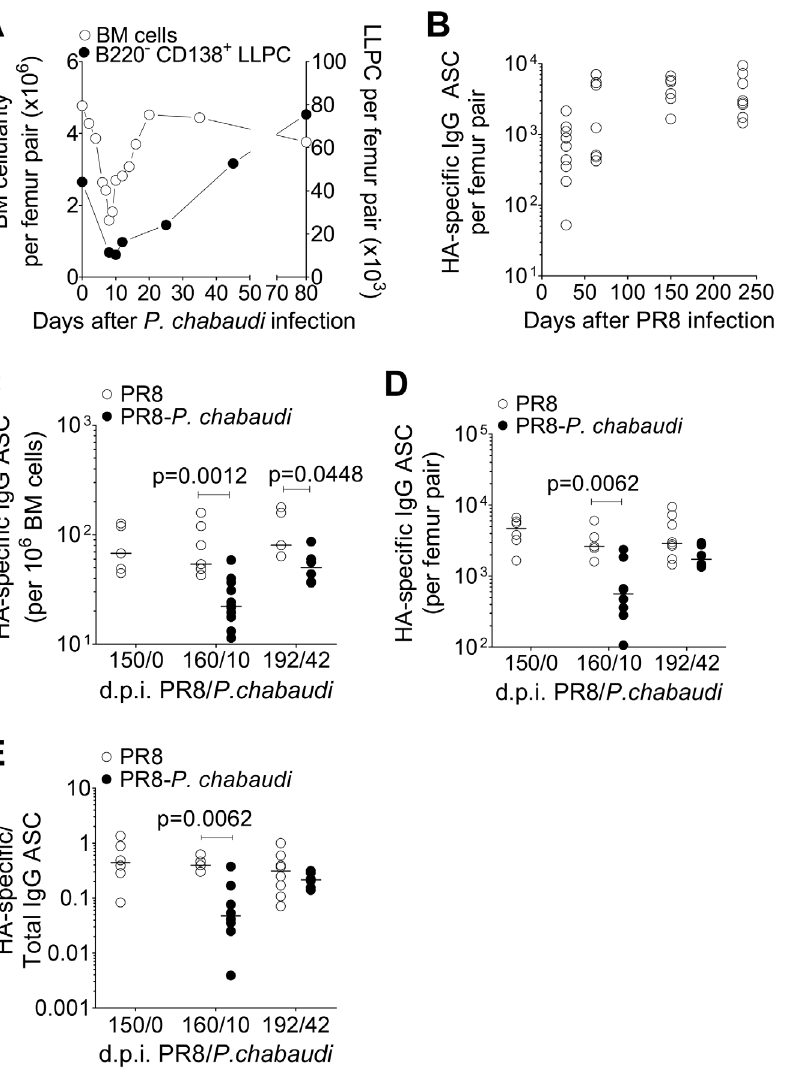
Figure 2. Loss of pre-established Influenza-specific bone marrow plasma cells during acute infection with P.chabaudi . Reduction in bone marrow cellularity during acute P. chabaudi infection. A. Absolute numbers of bone marrow cells per femur pair ( # ; left y -axis) and B220 2 N CD138 + long-lived plasma cells ( ; right y -axis) were quantified over the course of P. chabaudi infection. Each point is the median 6 S.E. of data obtained from one experiment with 3 mice per time point. B. 8–10 wk old female BALB/c mice were infected by intranasal instillation of 250 HAU of Influenza A/PR/8/34. 150 days later, they were infected with P. chabaudi . HA-specific IgG ASCs quantified by ELIspot at various times after P. chabaudi infection. Graph shows absolute numbers of HA-specific IgG ASC per femur pair [n=9 (d28); 8 (d63); 6 (d150) and 8 (d234)], and are pooled data